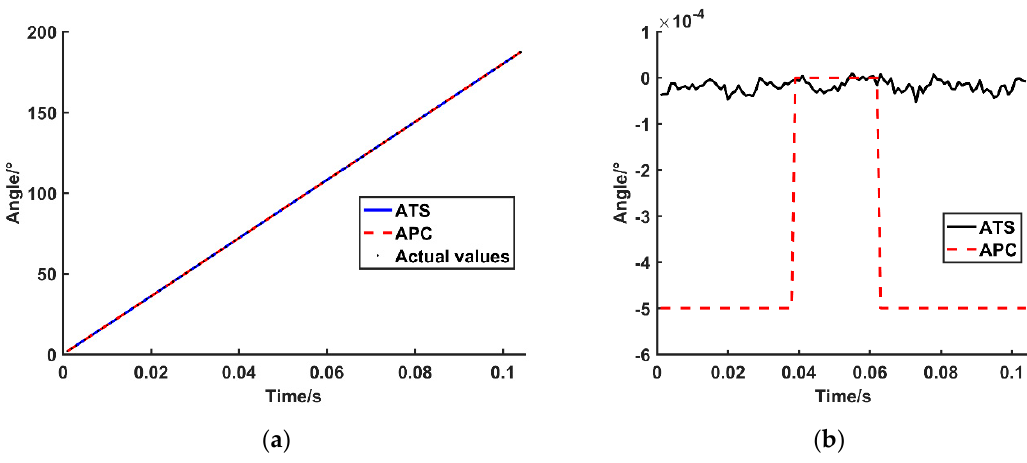
Figure 13. Angle comparison of different subdivision methods. ( a ) The encoder rotation angle obtained by two subdivision methods. ( b ) Angular deviation between calculated results and actual values with different subdivision methods.